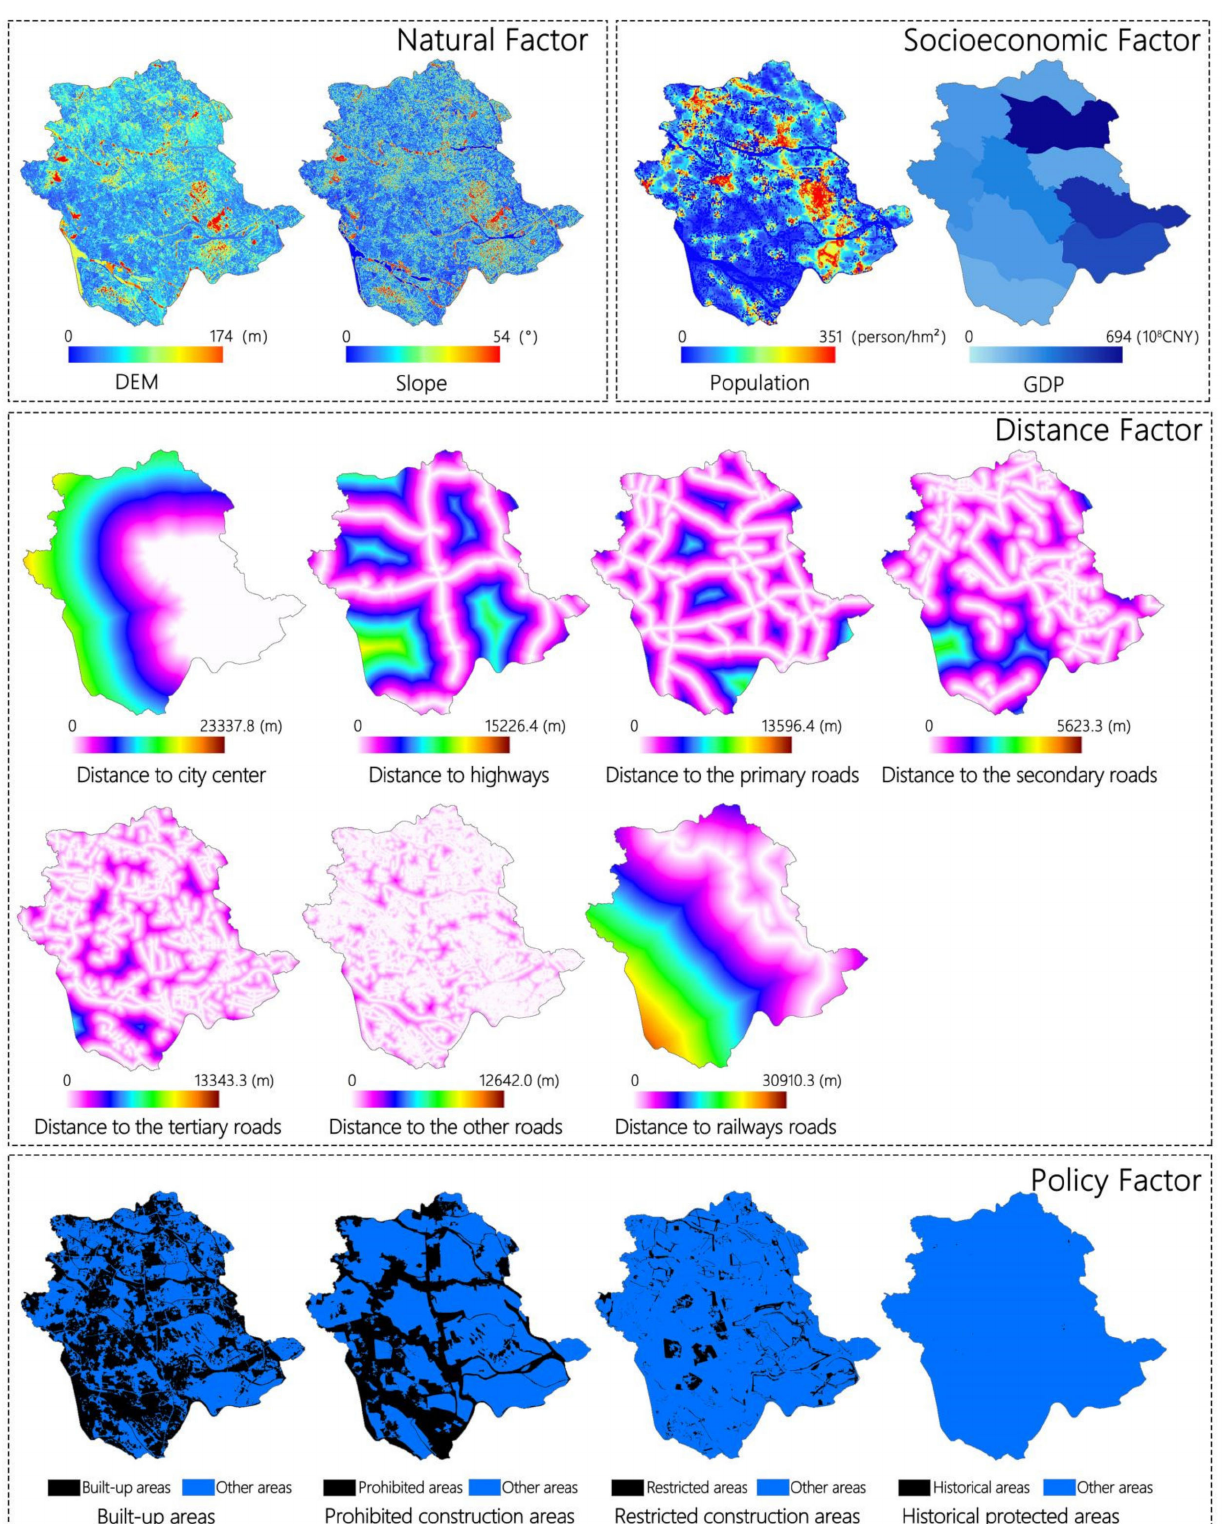
Figure 4. Suitability atlas of the multi-criteria